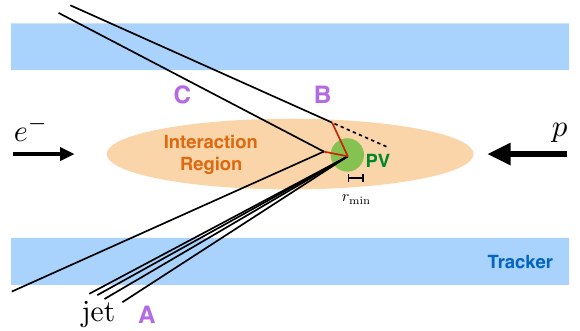
Figure 6 . Sketch of our LLP search strategy at e (cid:0) p colliders. Single or pair-production of weak- scale Higgsino LLPs (red) is practically always associated with the production of a hard jet (A) with p T > 20 GeV and (cid:17) < 4 : 7 which reaches the tracker and passes the trigger. The charged jet j j constituents (black) identify the primary vertex (PV). For Higgsinos decaying into e=(cid:22)=(cid:25) (cid:6) + (cid:31) 0 1 ; 2 (B), the LLP is detected if the charged particle trajectory (black solid and dashed) is reconstructed with p T > p min and has impact parameter greater than r min . For LLPs decaying into two or more T charged particles (C), a DV can be reconstructed, and the LLP is identi(cid:12)ed if the distance to the PV is more than r min . The electron or neutrino in the event as well as neutral (cid:12)nal states of LLP decay are not